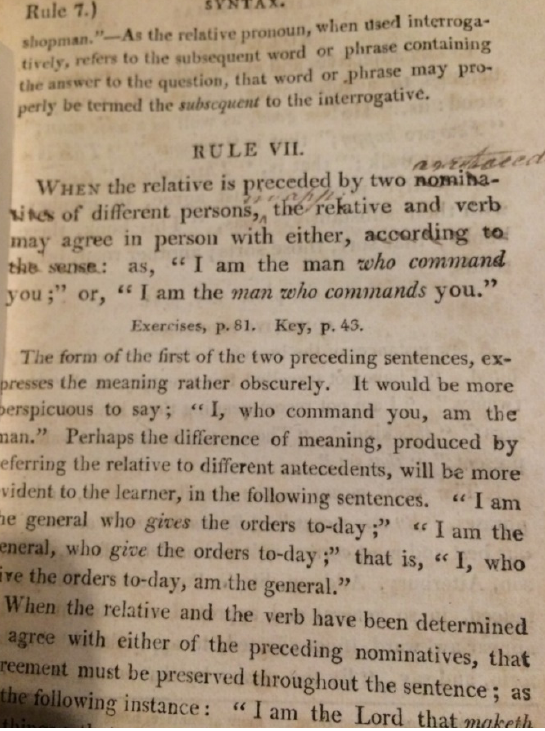
Figure 10. English Grammar as annotated by Charlotte Brontë.